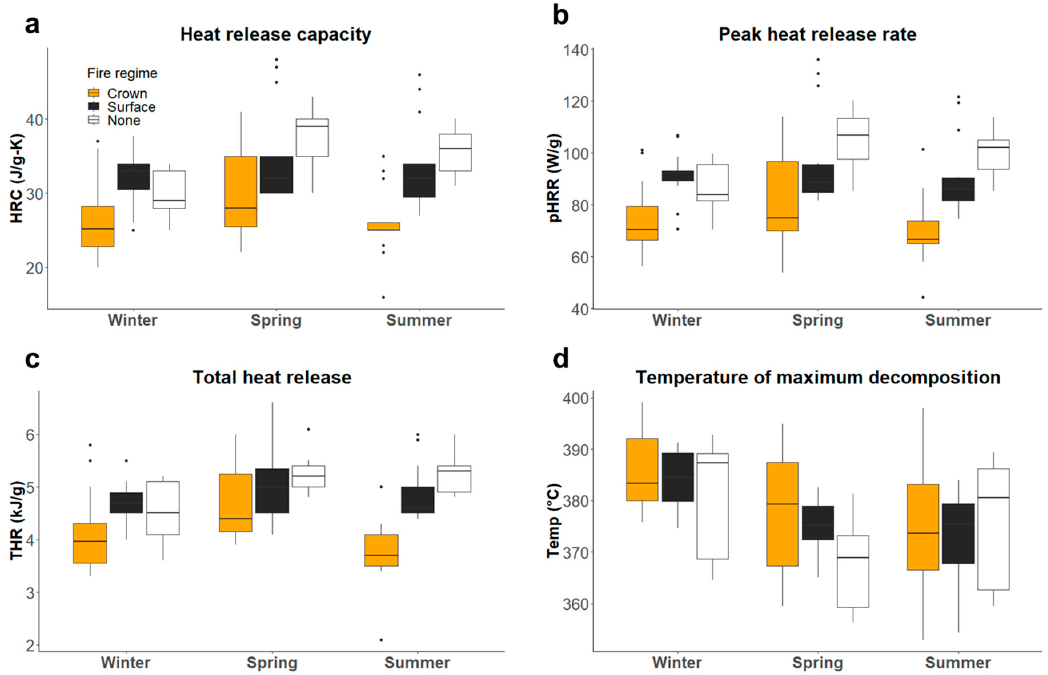
Figure 4. Flammability measurements of fresh pine needles. The flammability characteristics of fresh needles of pine species, grouped by fire regime and season, are shown. The flammability characteristics were determined by microcalorimetry analysis (( a )—heat release capacity; ( b )—peak heat release rate; ( c )—total heat release; ( d )—temperature of maximum decomposition). The boxes represent the interquartile range, with the median indicated; n = 15 (crown), 15 (surface) and 9 (none), with five species from both crown and surface fire regimes and three non-fire species.